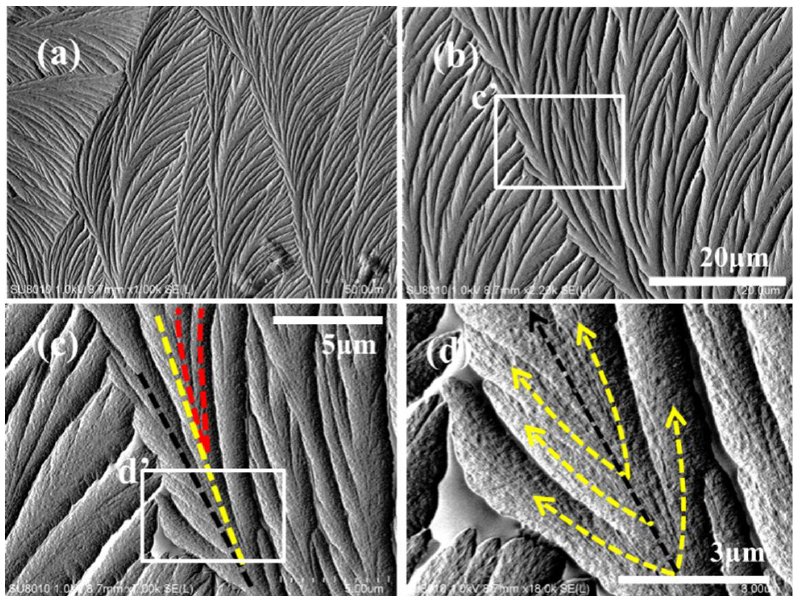
Figure 12. ( a ) SEM micrographs: ( b – d ) enlarged zoomed-in images of the squared regions—c’, and d’ of (S)-MA/PVPh (50/50) dendritic spherulite crystallized at T c = 45 °C. of (S)-MA/PVPh (50/50) dendritic spherulite crystallized at T